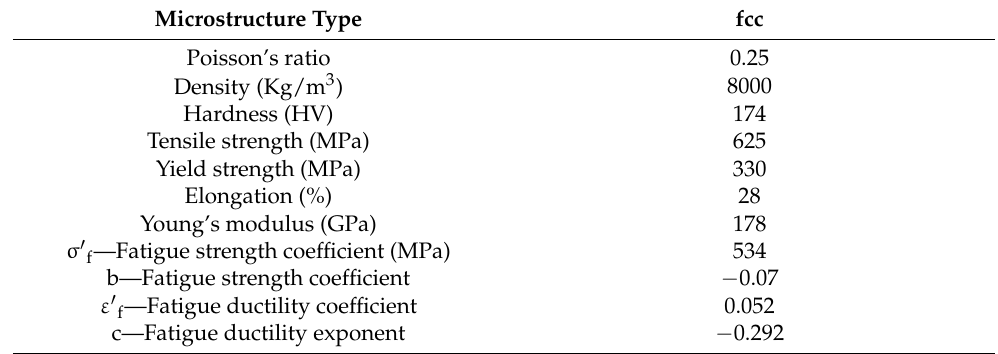
Table 2. AISI 303 mechanical properties.